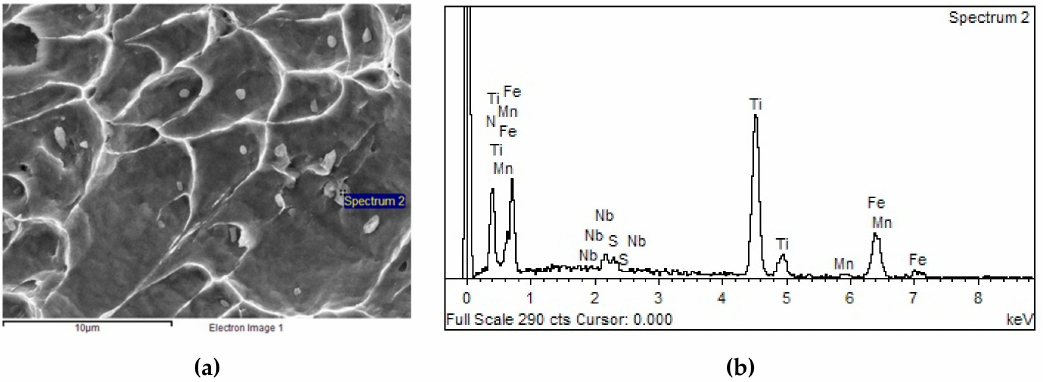
Figure 6. ( a ) Particles on the fracture, sample V1, T Q = 637 ◦ C, N f = 5.5; ( b ) EDX spectrum from the particle in Figure 6a.